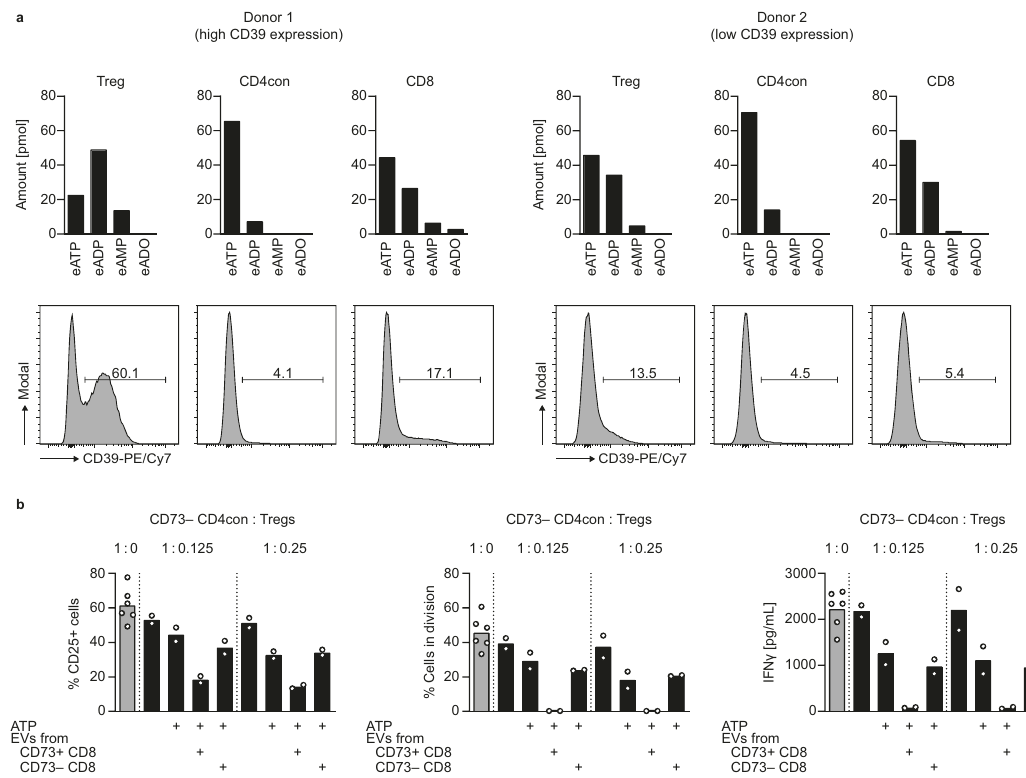
Fig. 6 The combined activities of Treg-derived CD39 and vesicular CD73 result in optimal suppression of T cell function. a Analysis of ATPase activity in sorted T cell subsets of two donors by HPLC. Activated cells ( α CD3/ α CD28, 3 days) were incubated with 1, N 6 -etheno-ATP (eATP) and degradation of etheno-nucleotides was determined by HPLC. Histograms show CD39 expression on the cells at the time of eATP incubation. b CD73 − CD4con T cells were stimulated with α CD3/ α CD28 in the presence of the ADA inhibitor EHNA (10 µ M) and incubated with Tregs, ATP (50 µ M), and EVs from cell culture supernatants of sorted and activated CD8 T cells as indicated. CD25 expression and proliferation were measured after 4 days by fl ow cytometry. IFN γ production was determined by ELISA in the cell culture supernatant harvested on day 4. Data were shown for one representative donor out of four analyzed (mean of technical